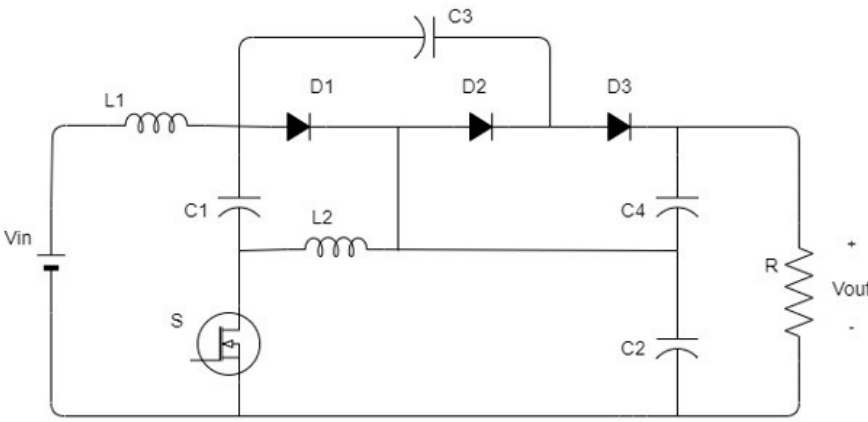
Figure 4. Topology of SCZEB converter [12].